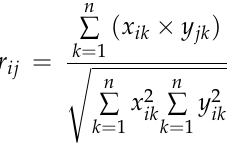
Figure 7. Comparison between the best GMDH and GOA-SVM models for training and testing ac-